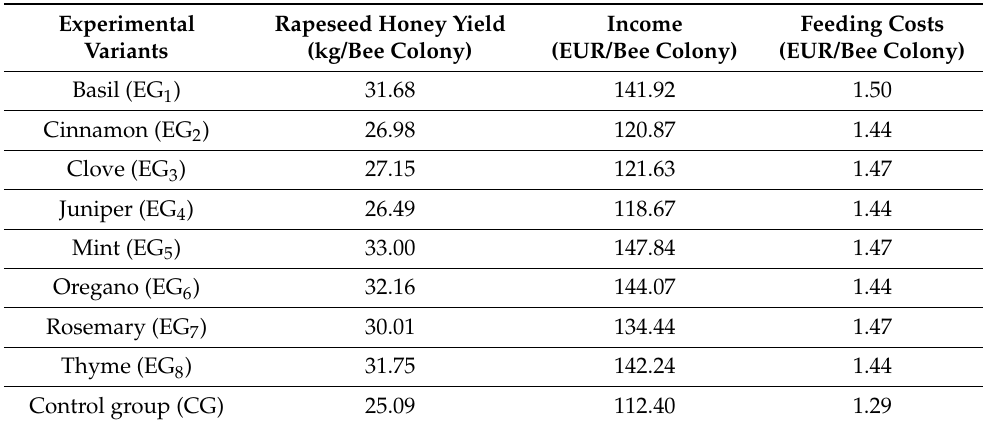
Table 3. The economic benefits of using essential oils as supplements in the stimulation feed adminis- tered to bee colonies. Experimental Rapeseed Honey Yield Variants (kg/Bee Colony)